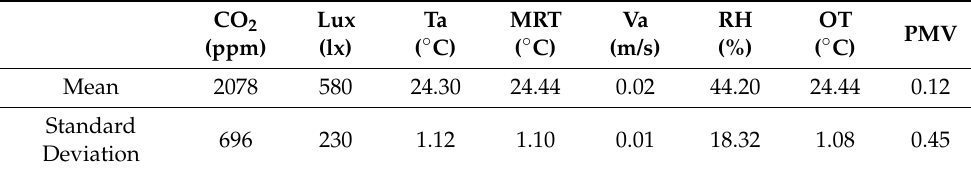
Table 3. Indoor environment in target classrooms (5 min before the end of class).